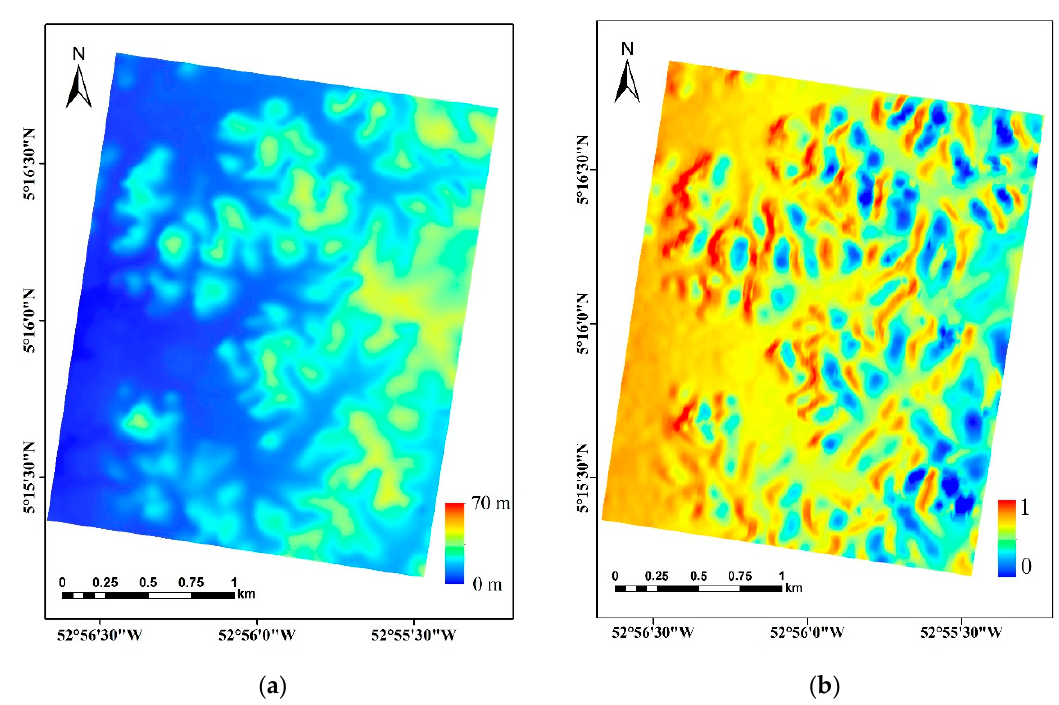
Figure 7. DTM product of polarimetric interferometric SAR (Pol-InSAR) ( a ) and terrain compensa- tion factor ( b ) of the study area.